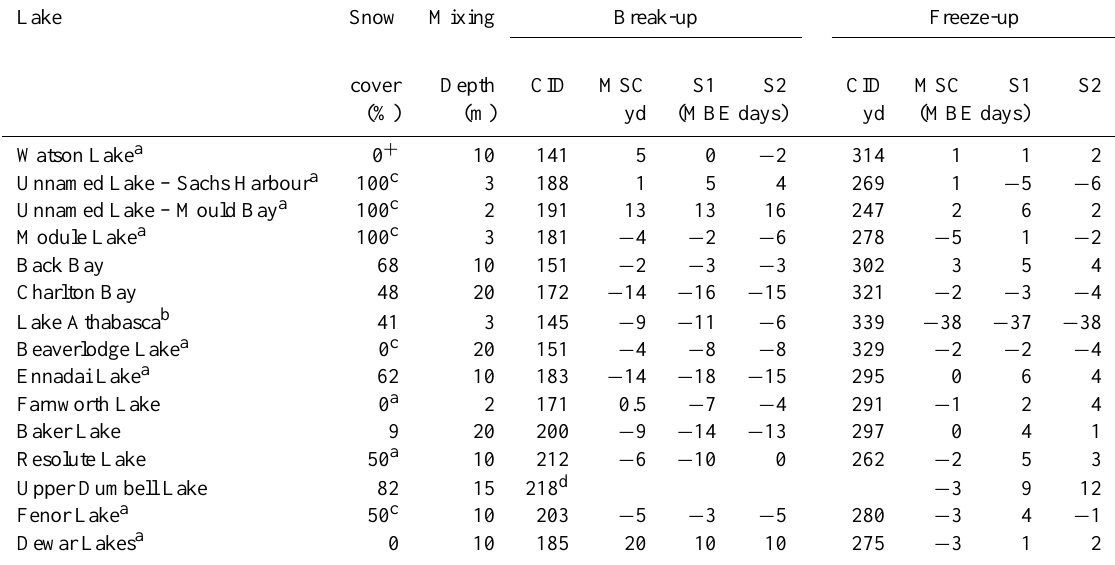
Table 3. Mean bias error (MBE) in break-up and freeze-up dates from simulations using Meteorological Service of Canada (MSC) data, CRCM scenario 1 (S1) and scenario 2 (S2) for the validation sites along with the mean observed break-up and freeze-up from the Canadian Ice Database (CID) (dates as indicated in Table